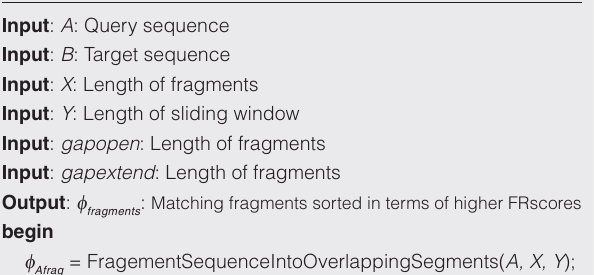
Algorithm 1: FRAGAL() - A fragmented alignment